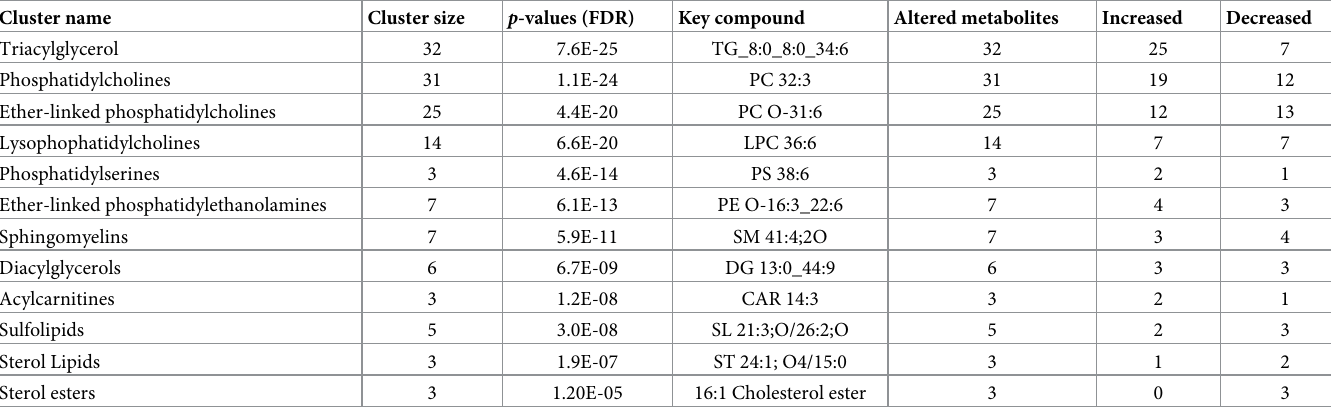
Table 1. Results of the ChemRICH enrichment analysis for the altered metabolites following the comparison L+P vs CTRL diets. Cluster